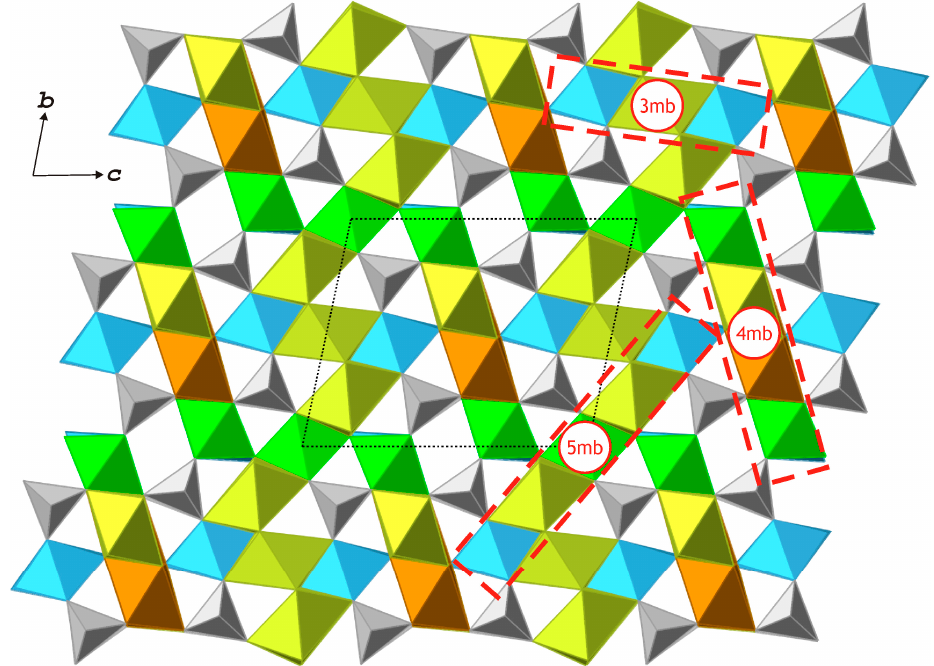
Figure 6. The crystal structure of chirvinskyite projected along the a -axis. Red dashed lines outline sections of three-membered, four-membered, and five-membered (3mb, 4mb, 5mb, respectively) octahedral walls. For the A sites, only the A -O bonds shorter than 2.6 Å are taken into account. Legend: Ca polyhedra = light-blue, Fe polyhedra = brown, Na polyhedra = yellow, Zr polyhedra = green, and Si tetrahedra = gray.